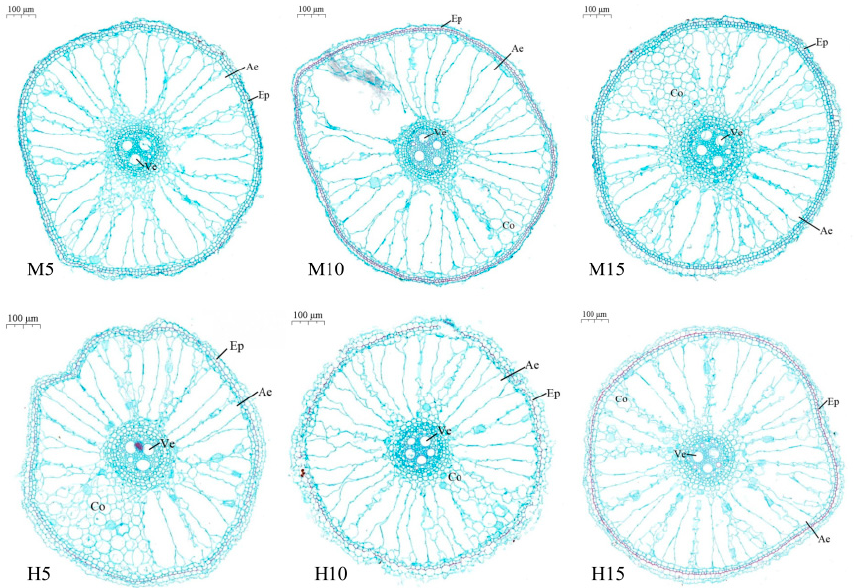
Figure 5. Cross-sectional map of root anatomy of rice at 10 days (19 August) after high temperature and waterlogging stress.